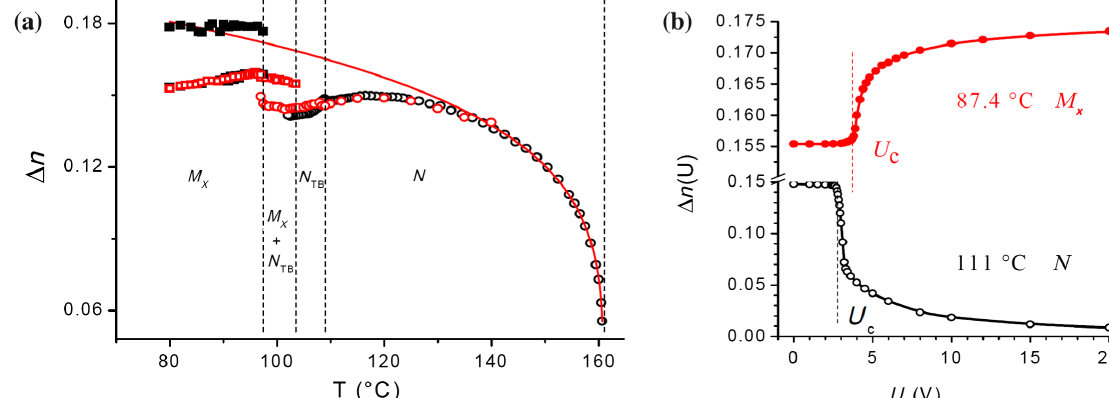
FIG. 6. Temperature and field dependence of the birefringence of the BP12 mixture. (a) Δ n ð T Þ measured in different phases and for different sample alignments. The black symbols show the data obtained using PMT detection, whereas the red symbols show the data measured with the image-mapping technique. The circles show the data Δ n ¼ n k − n ⊥ , obtained in the uniaxial N and N phases or TB − n , obtained in the M phase without a field. The full squares show the regions, whereas the open squares show the data Δ n ¼ n nn mm X − n data Δ n ¼ n in the M phase, obtained by extrapolation of the results measured under a field. The red line shows the nn kk X birefringence expected by extrapolation of the Haller fit [53] of the data in the range 140 °C – 160 °C. (b) Δ n ð U Þ in the N (black symbols) and M (red symbols) phases. X